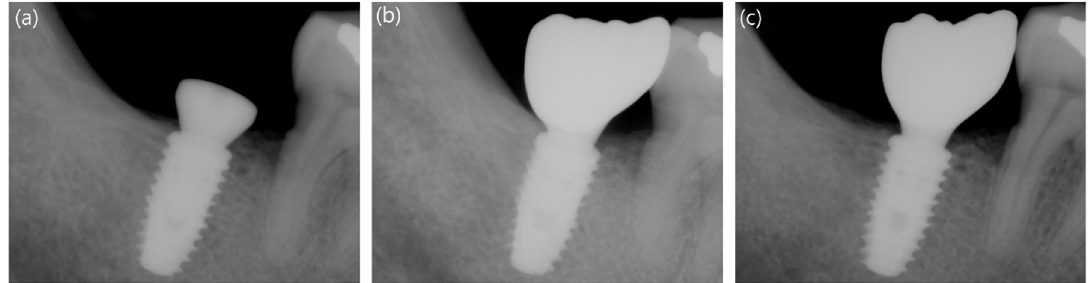
Figure 4. Standard periapical radiographs of implants placed in a patient in the control group (CMI IS-III active ® long implant, Neobiotech Co., Seoul, Korea): ( a ) at surgery, ( b ) at 12 weeks, and ( c ) at 48 weeks.